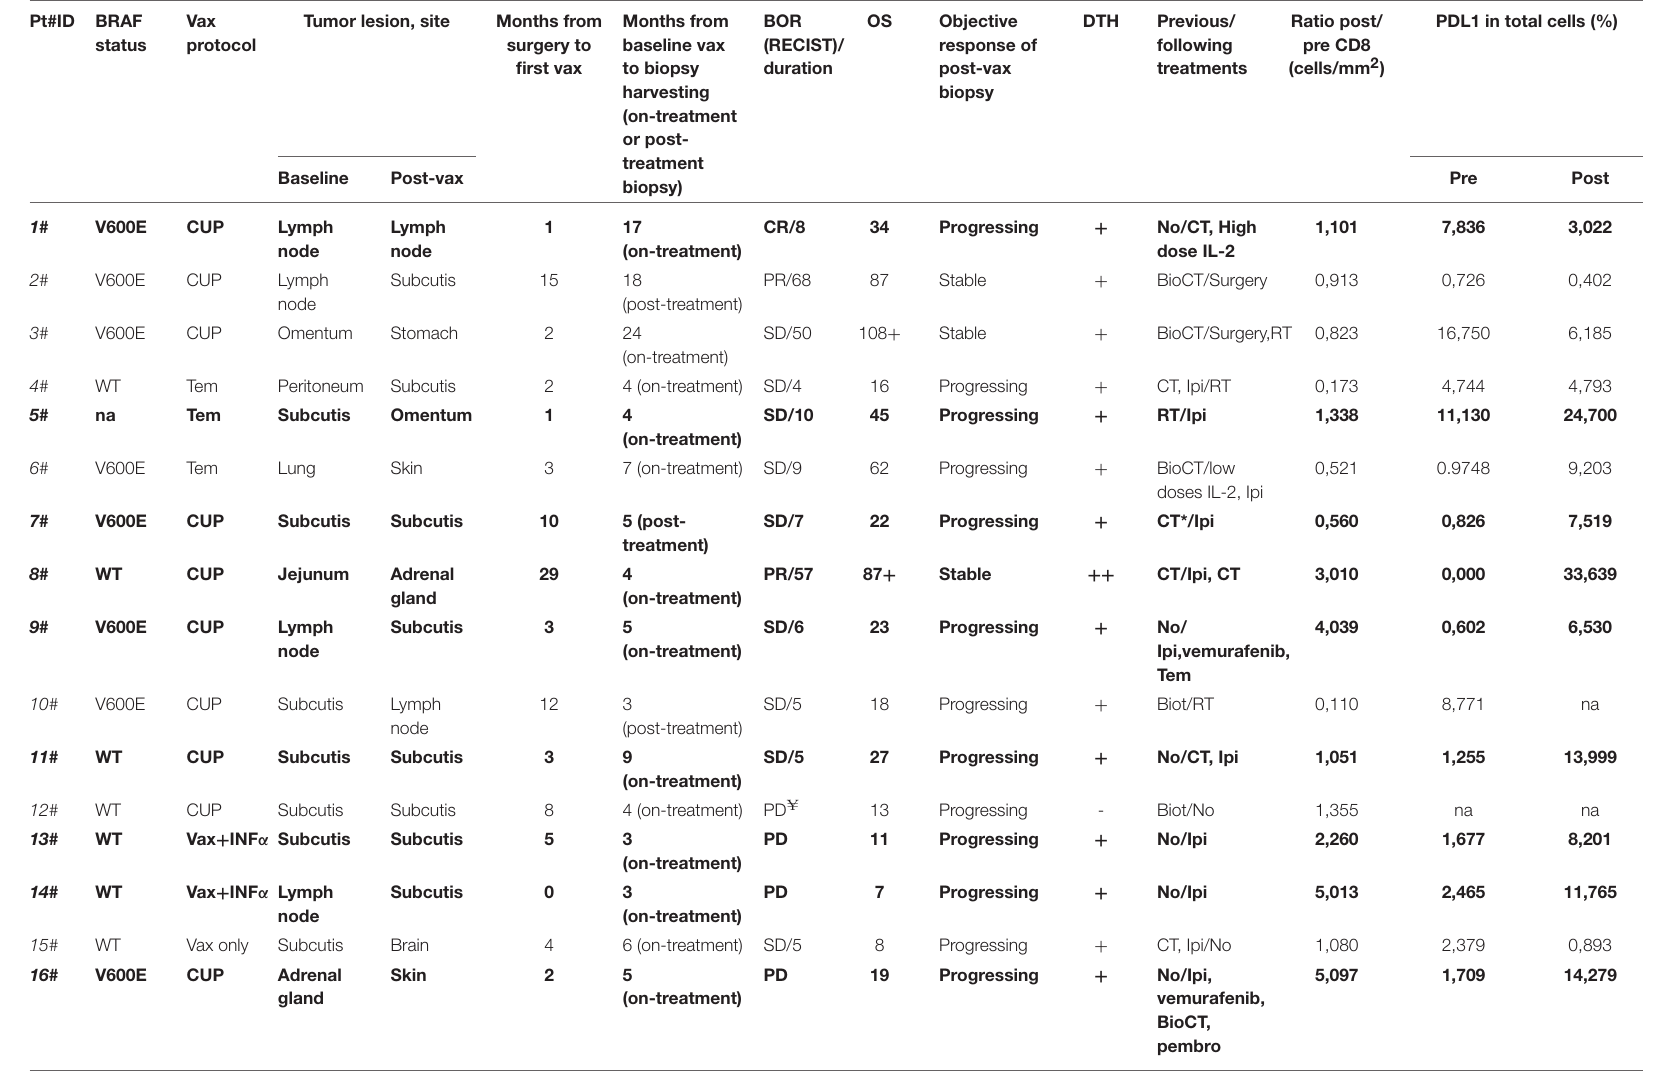
Vax, dendritic cell vaccination; DTH, delayed-type hypersensitivity; WT, wild type; CUP, compassionate use program; CT, chemotherapy; CT * , chemotherapy third line; RT, radiotherapy; Tem, temozolomide; IFN α , interferon alpha; IL-2, interleukine 2; Biot, low doses of cytokines (IL-2 and/or IFN α ); BioCT, cytokine + chemotherapy; Ipi, ipilimumab; pembro, pembrolizumab. Naïve/CT/RT patients are highlighted in bold. U Pt#12 was treated beyond progression after surgical removal of the progressing